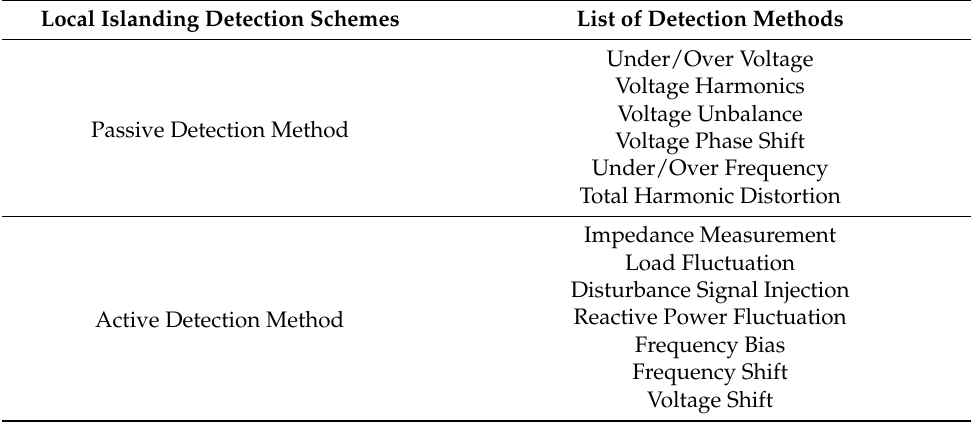
Table 1. Local Islanding Detection-Based Schemes.